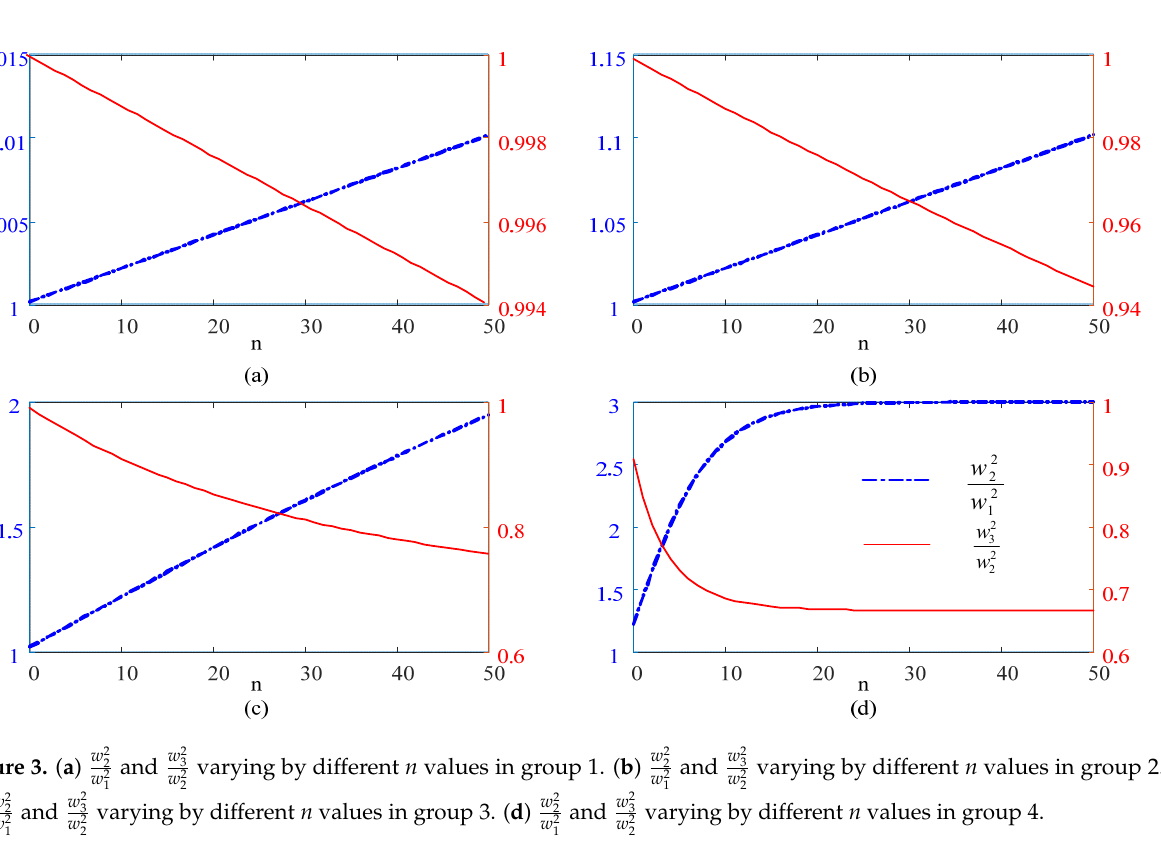
w 2 3 w 2 2 and values calculated by the traditional information entropy w 2 w 2 2 1